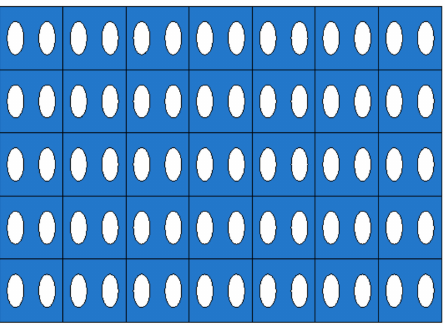
Figure 2. Shape of orthotropic